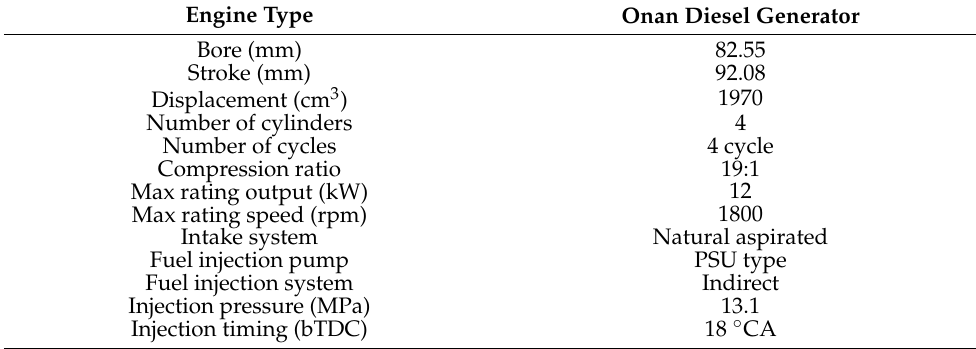
Table 1. Technical specifications of test